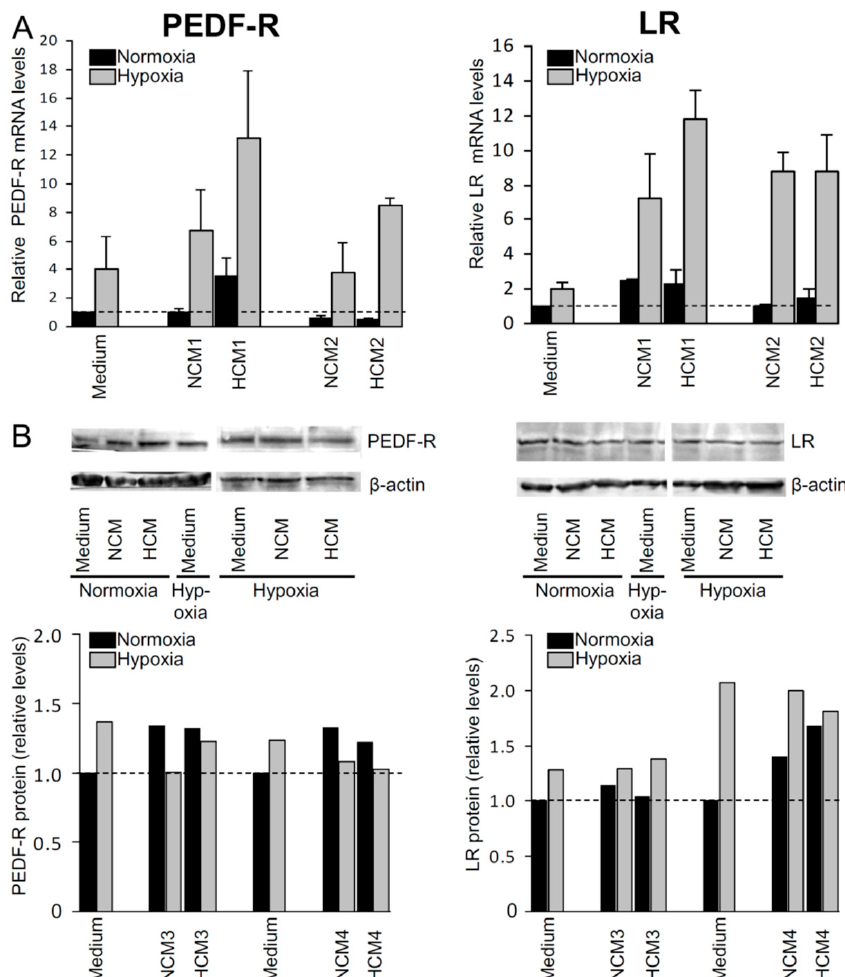
Figure 2. Soluble factors secreted by Müller cells enhance expression of PEDF receptors in R28 cells. R28 cells were cultured for 24 h under normoxia or hypoxia (0.2% O 2 ), in the presence (NCM or HCM) or absence (“medium”) of Müller-cell conditioned media. The effect of these media on PEDF-R and LR ( A ) mRNA and ( B ) total protein expression was determined by ( A ) semi-quantitative real-time PCR and ( B ) Western blotting, respectively. Basal expression levels ( dashed lines) relate to R28 cells cultured under normoxia in basal medium. Data in ( A , B ) are each derived from two independent experiments and ( A ) are expressed as means ± standard deviation and ( B ) summarize Western blotting analyses of PEDF receptor to β -actin protein expression ratios. Experiments were performed with conditioned media (1–4) derived from Müller cells of four different retinae (NCM: normoxia-conditioned media; HCM: hypoxia-conditioned media).